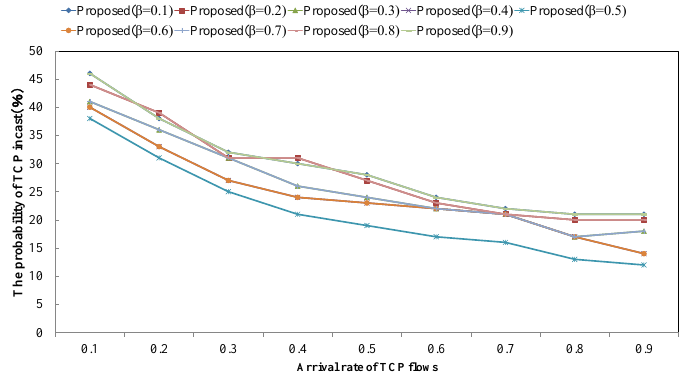
Figure 13. The probability of TCP incast occurrence against learning parameter: β